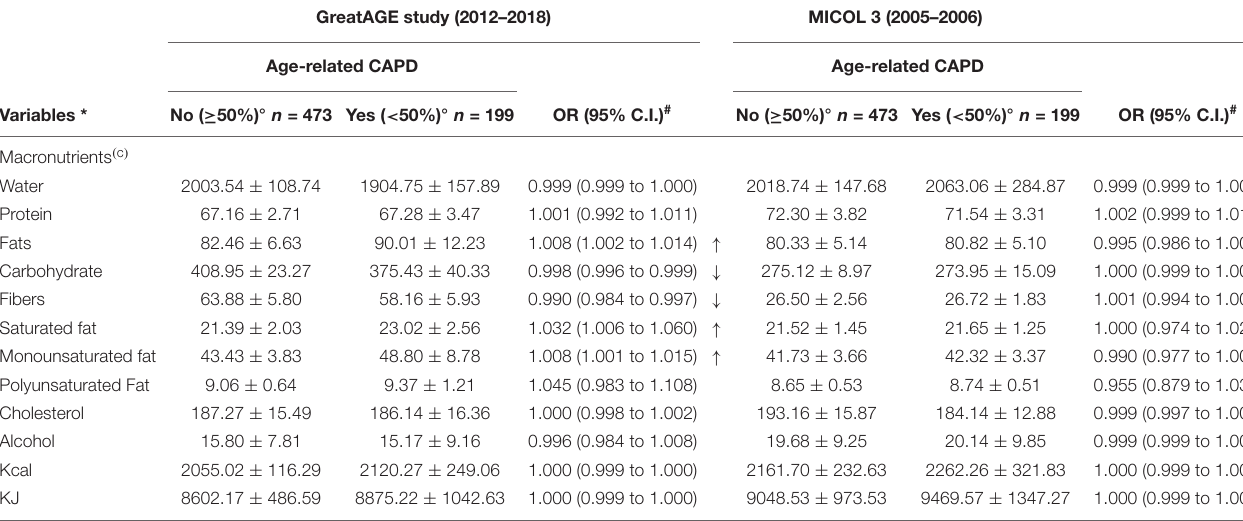
TABLE 4 | Macronutrient intake characteristics of the population at baseline (M3) and follow-up (GreatAGE study) ( n = 734, non-age-related CAPD n = 473, age-related CAPD n = 199, missing n =